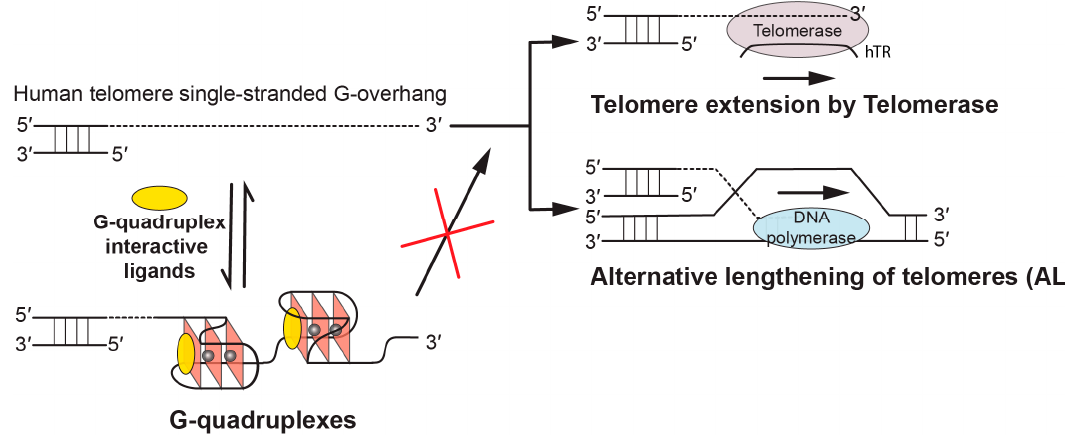
Figure 1. Biological implications of targeting telomeric G-quadruplexes using G-quadruplex-interactive ligands. In human tumors, the free single-stranded telomere G-overhang can be extended by telomerase, which reverse transcribes the template region of its RNA subunit (hTR), or by alternative lengthening of telomeres (ALT), which copies telomeric template DNA via homologous recombination. G-quadruplex-interactive ligands can promote the formation of and stabilize the telomeric G-quadruplex structures, thus inhibiting telomere extension processes which are required for the indefinite growth of human tumors.